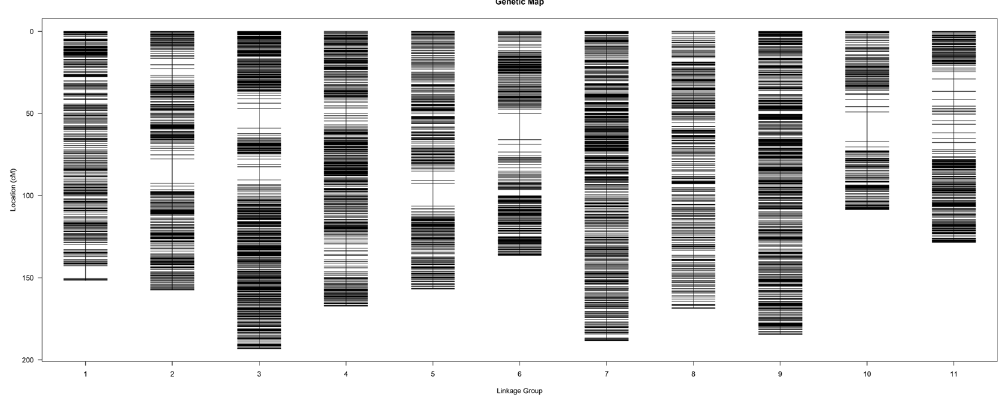
Figure 1. A high-density genetic linkage map constructed for the Vigna vexillata F 2 population of a cross between ‘TVNu 240’ and ‘TVNu1623’ using 6,529 SNP markers from the SLAF